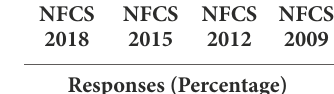
TABLE 1 OFL questions and the statistics of responses.